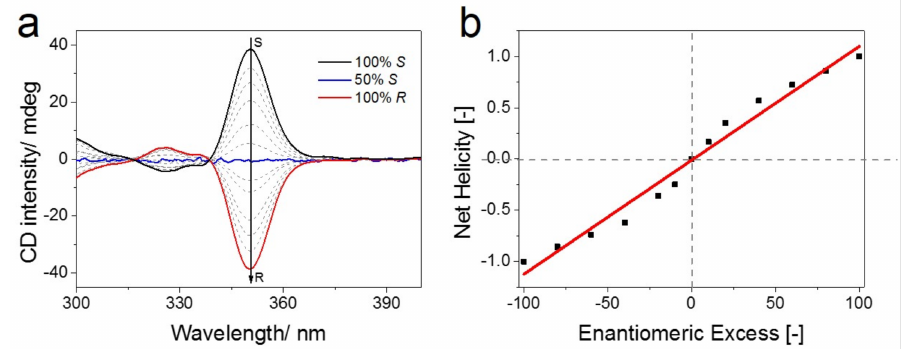
Figure 3. ( a ) CD spectra recorded at room temperature of mixtures of different ee as indicated by the arrow from pure ( S )- 2 through ee = 0% (1:1 mixture) to pure ( R )- 2 . ( b ) The net helicity as function of the ee